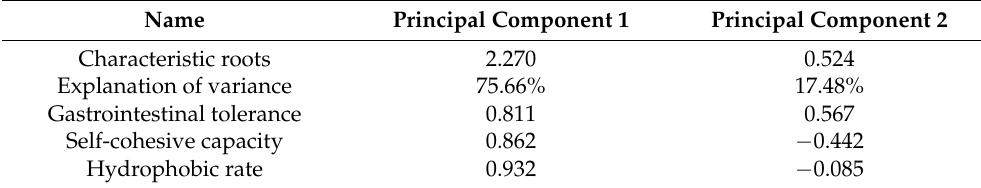
Table 2. Load factor